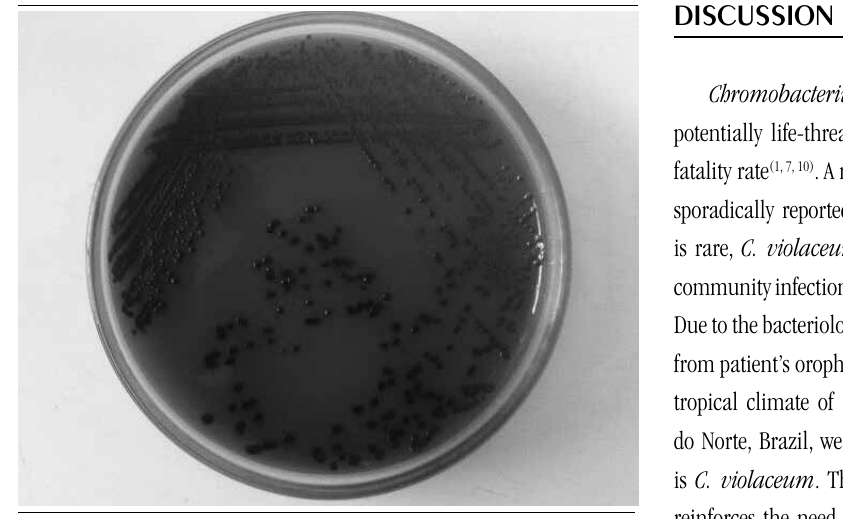
figurE – Pigmented colonies observed on the blood agar plate after 24 hours of incubation, typical of Chromobacterium